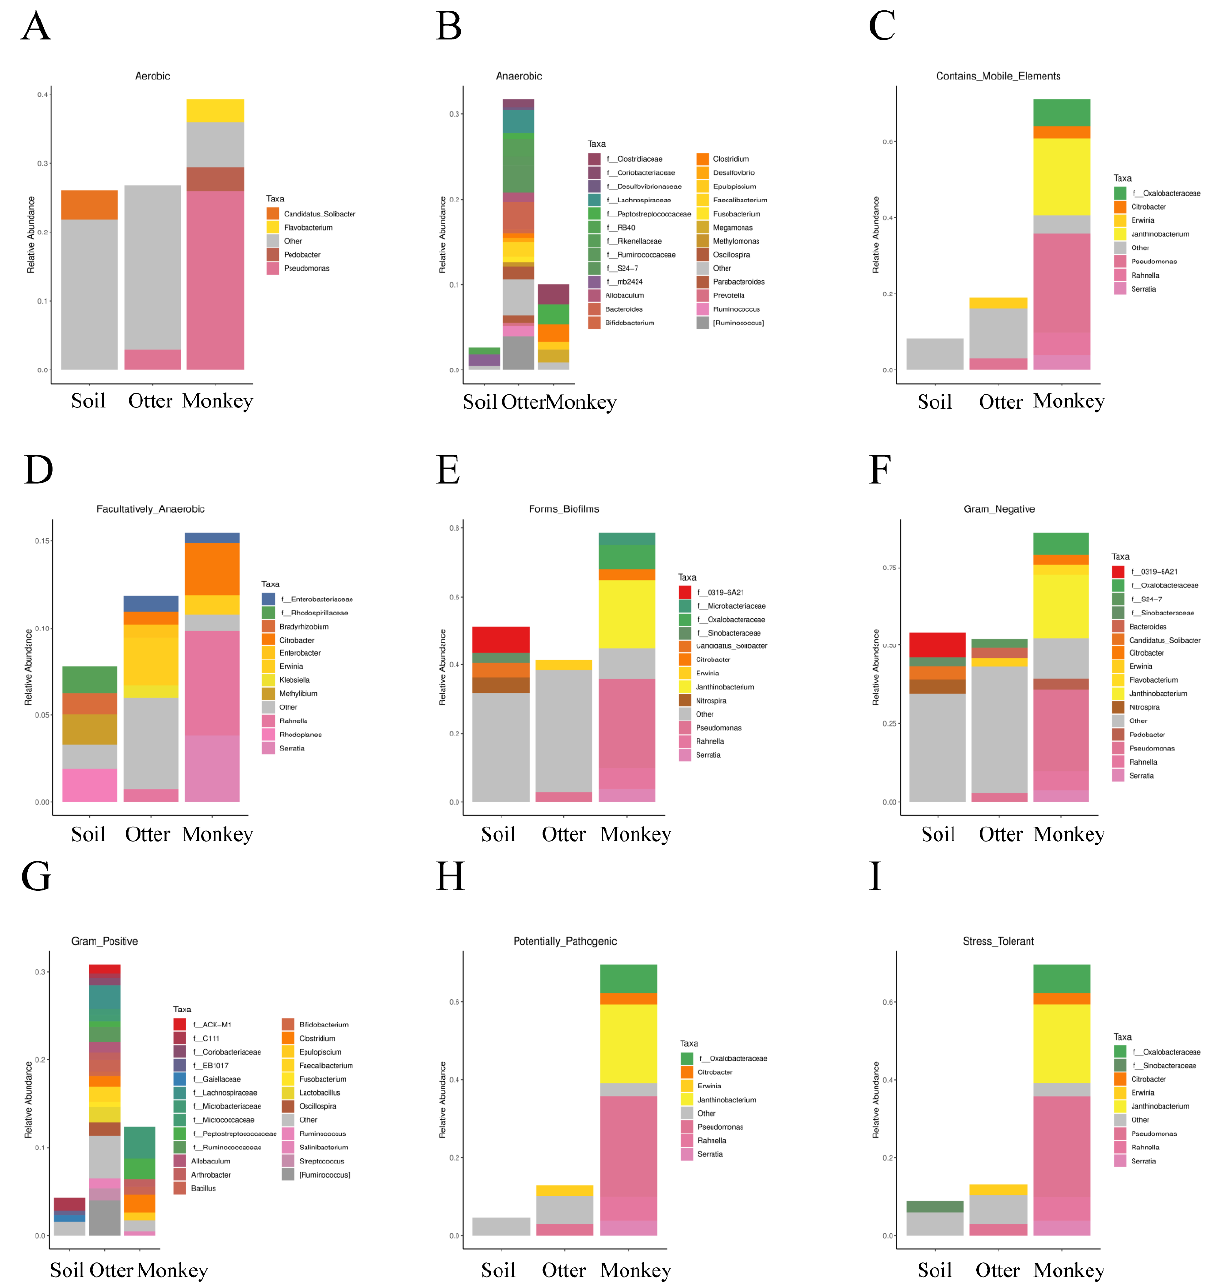
Figure 7. Microbiota phenotype prediction of the habitat soil microbiome and gut microbiomes of Eurasian otters and golden snub-nosed monkeys: “aerobic” ( A ), “anaerobic” ( B ), “contains mobile elements” ( C ), “facultatively anaerobic” ( D ), “forms biofilms” ( E ), “Gram-negative” ( F ), “Gram- positive” ( G ), “potentially pathogenic” ( H ), and “stress-tolerant” ( I ) phenotypes.